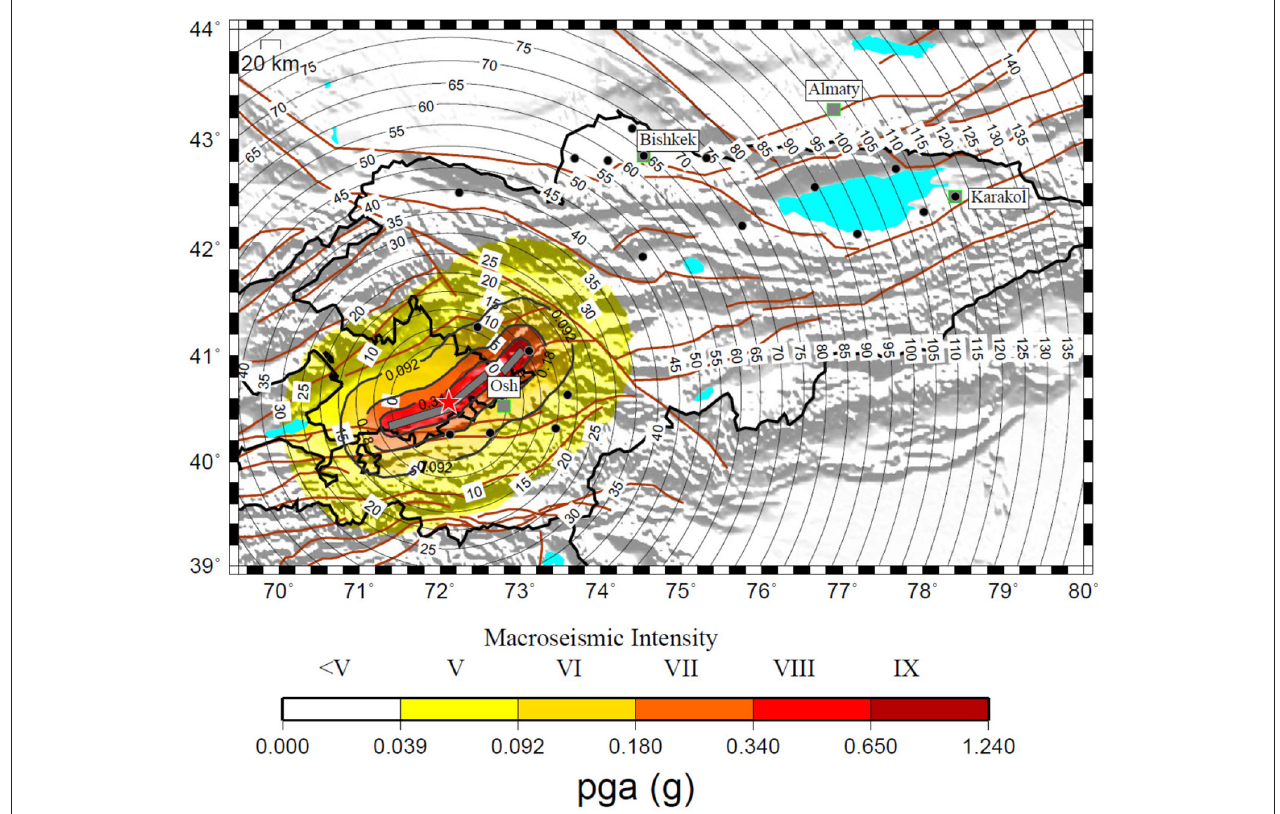
FIGURE 13 | As in Figure 11 , but for a scenario involving the Ferghana Valley fault system (M 7.5, red